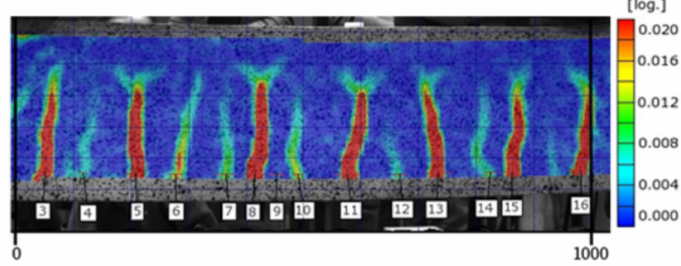
Figure 15. Strain map for beam C2M-1 at the load level of 0.95. Analysis of the strain map indicates local strain accumulations at the lower zone of the beam in tension, identified as cracks in concrete (brittle